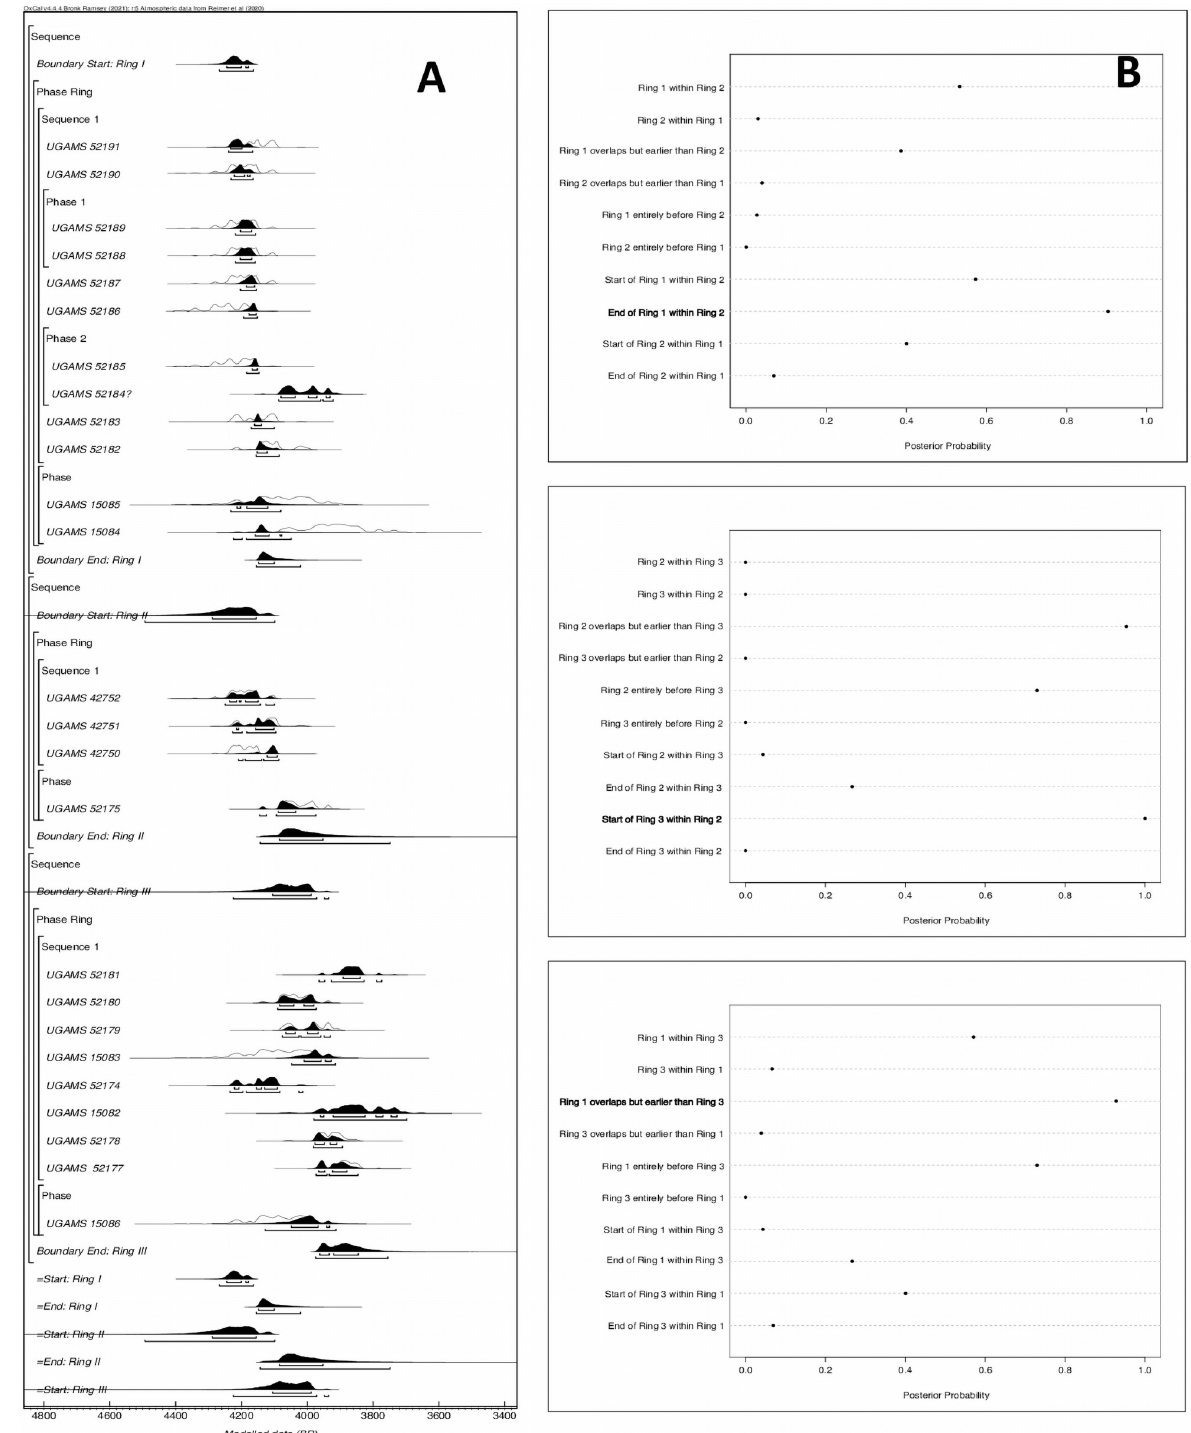
Fig 2. AMS models: (A) Probability distributions; (B) Posterior probability of the chronological relationships for the start and end date of the Sapelo shell rings.